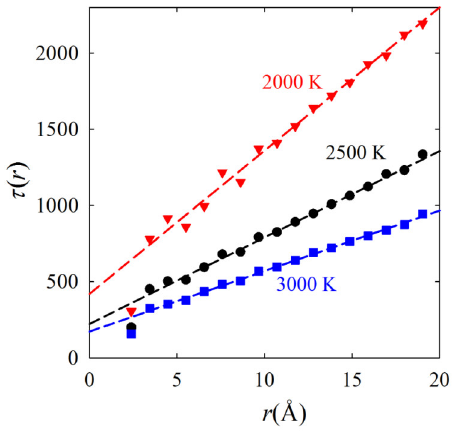
Figure 8. Temperature dependence of the Maxwell relaxation time (circle) and τ LC determined from the Van Hove function (diamond) for water, in pico-second [37].